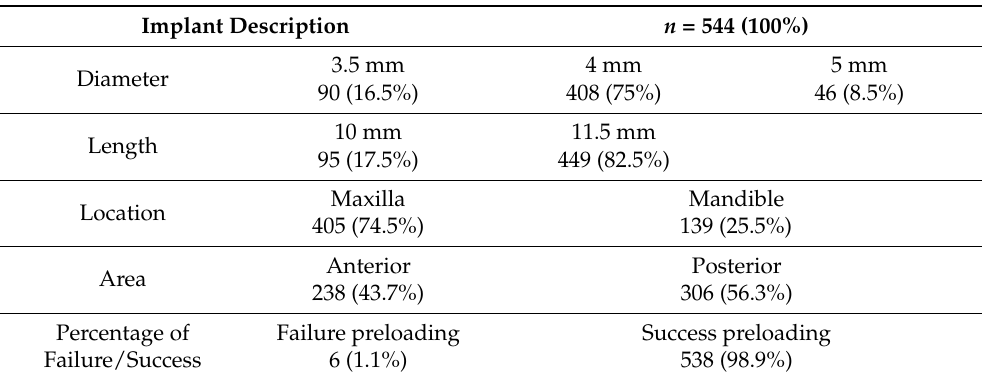
Table 2. Distribution of the implant characteristics: diameter, length, location, area of placement, and preloading percentage of failure/success.